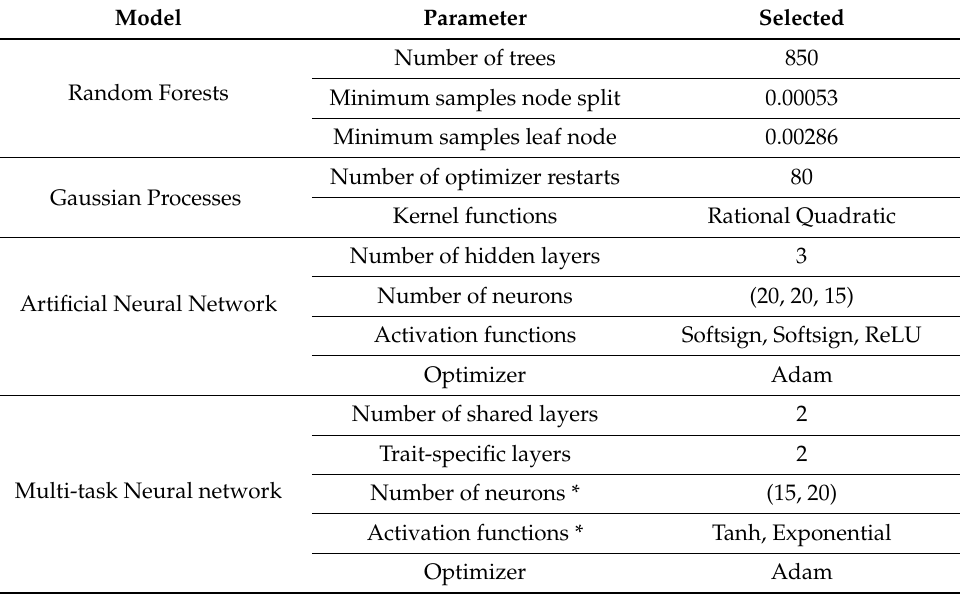
Table 4. Summary of selected hyperparameters. * on the multi-task network are related to the shared layers; task-specific parameters are given in Table 5.